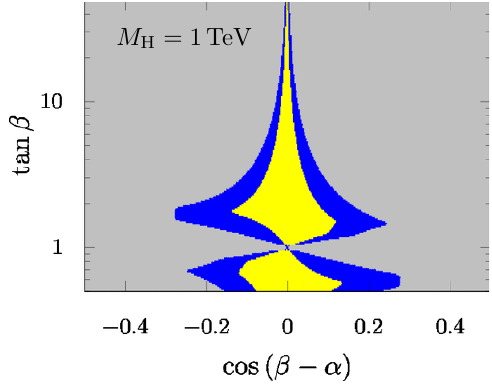
Figure 7 . The perturbativity measure for M H = 1 TeV with the remaining parameters as in the scenario of (cid:12)gure 4. Large areas are excluded by coupling factors (cid:21)= (4 (cid:25) ) > 1 (gray) whereas values between 0.5 and 1 (0.3 and 0.5) are coloured blue